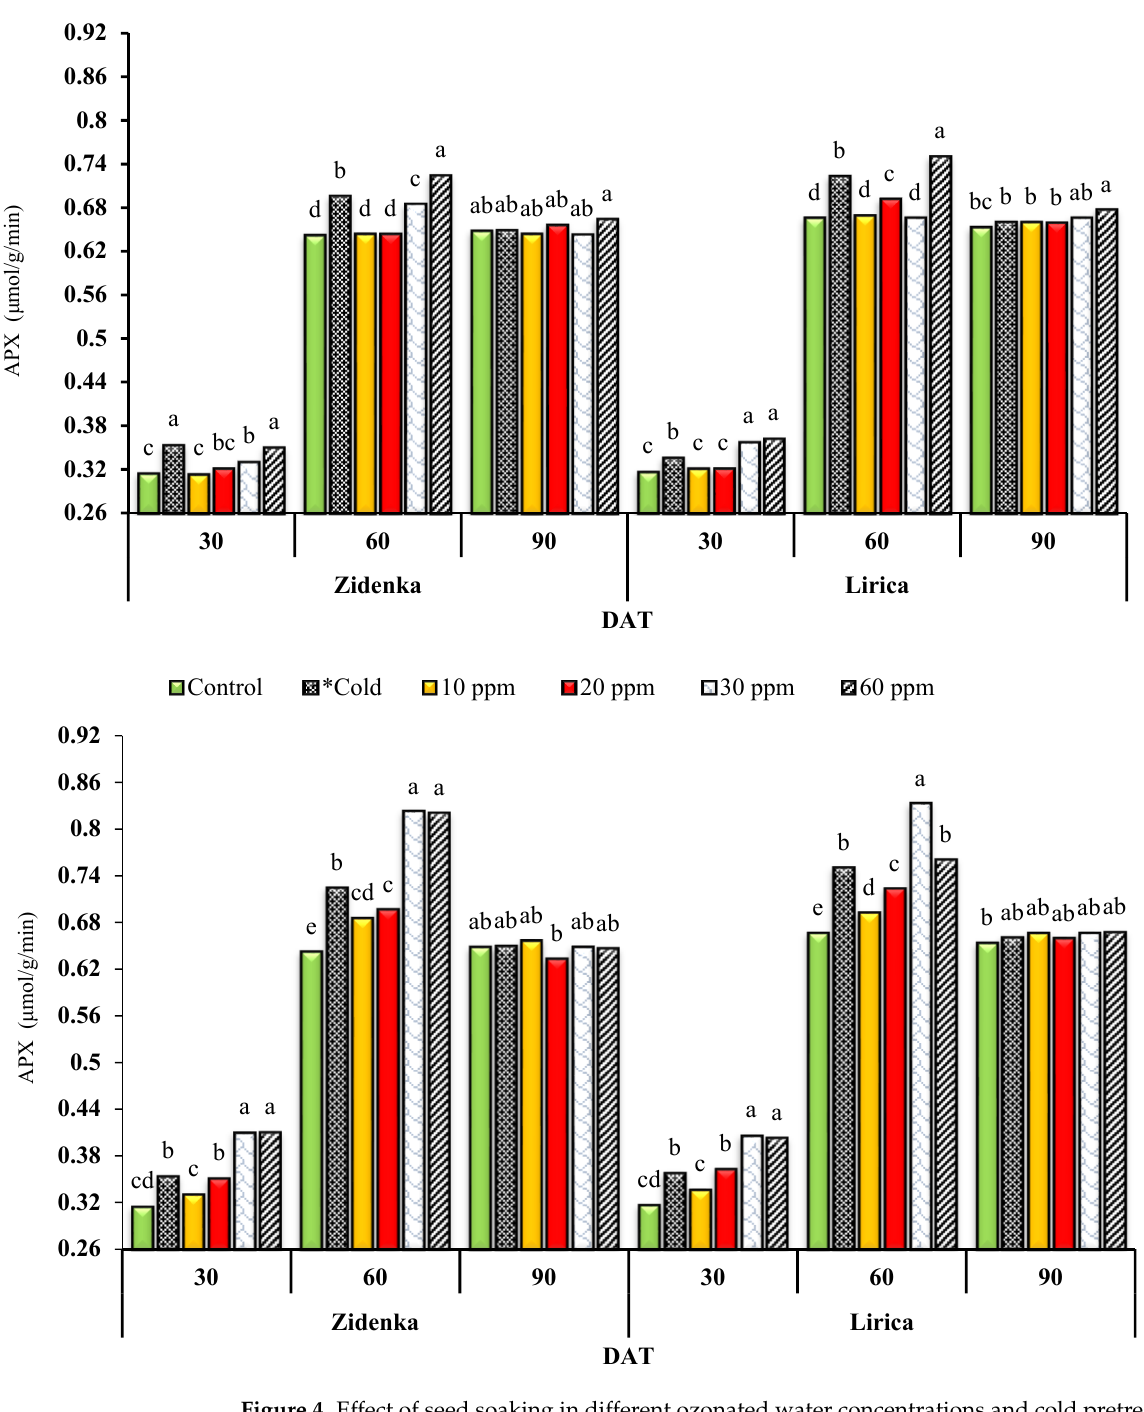
Figure 4. Effect of seed soaking in different ozonated water concentrations and cold pretreatments on APX activity of two pepper hybrids 30, 60, and 90 days after transplanting during the 2017/2018 ( upper figure) and 2018/19 ( lower figure) seasons. The column followed by a lowercase letter are not significantly different according to Duncan’s multiple range test at 0.05 levels for the same sampling date of each season and each hybrid separately. * cold treatment was performed at 4 ◦ C for 36 h. The average value of three biological and three technical replicates is